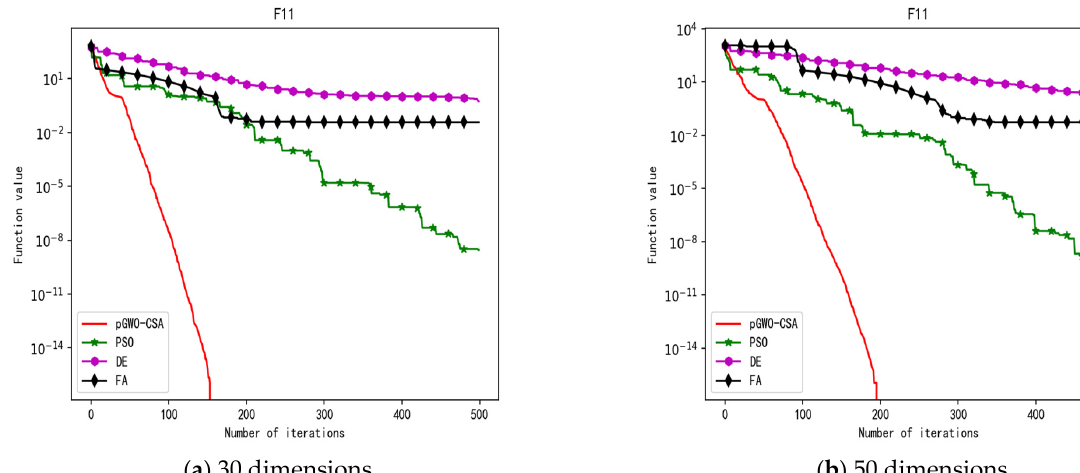
Figure 14. Convergence curve of test function F10.